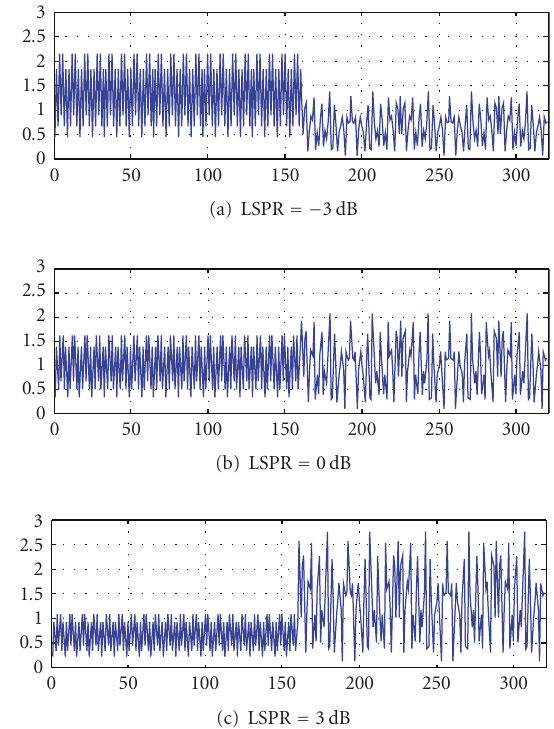
Figure 8: Normalized power sequence of preamble according to